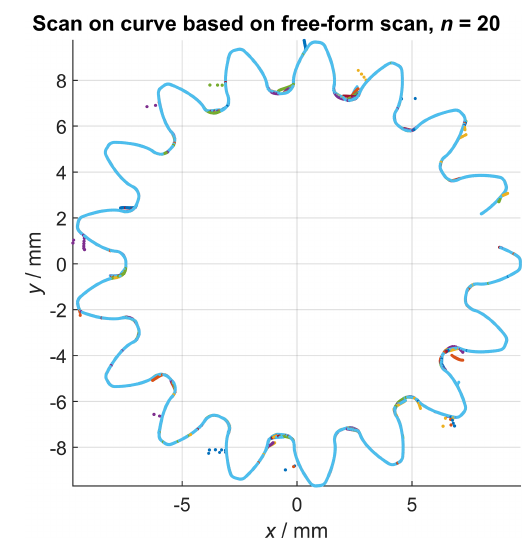
Figure 3. Visualization of repeated gear profile scans ( n = 20) us- ing the functionality scan on curve based on a free-form scan